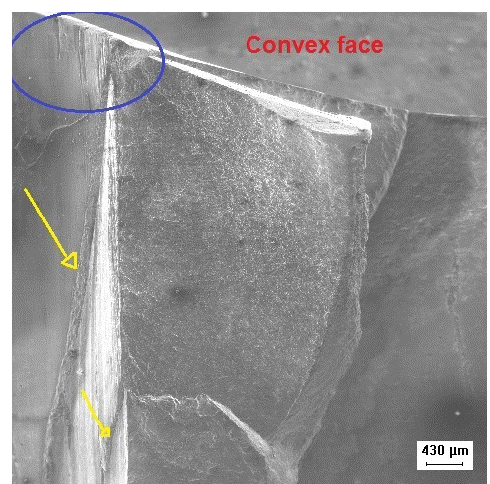
Figure 12. SEM images of the fracture surface of the P2 blade.